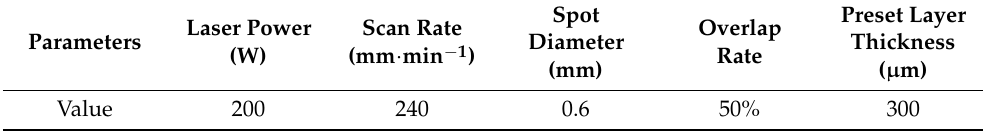
Table 1. Process parameters of laser